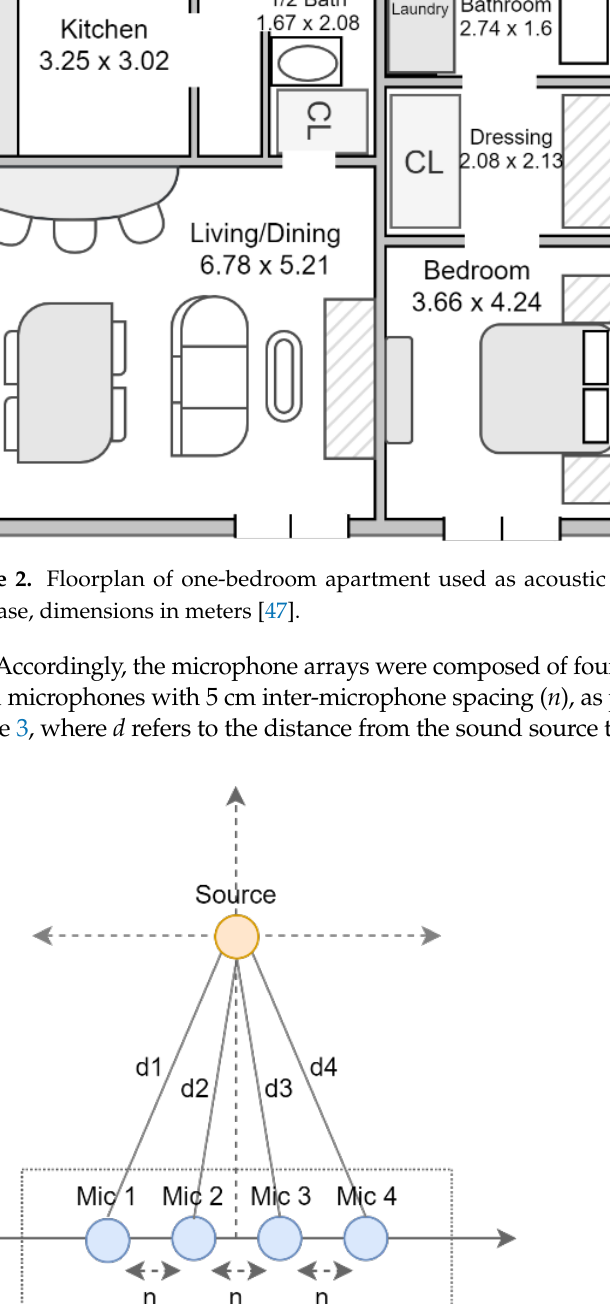
Figure 3. Microphone array geometry for a single node: four linearly spaced microphones.